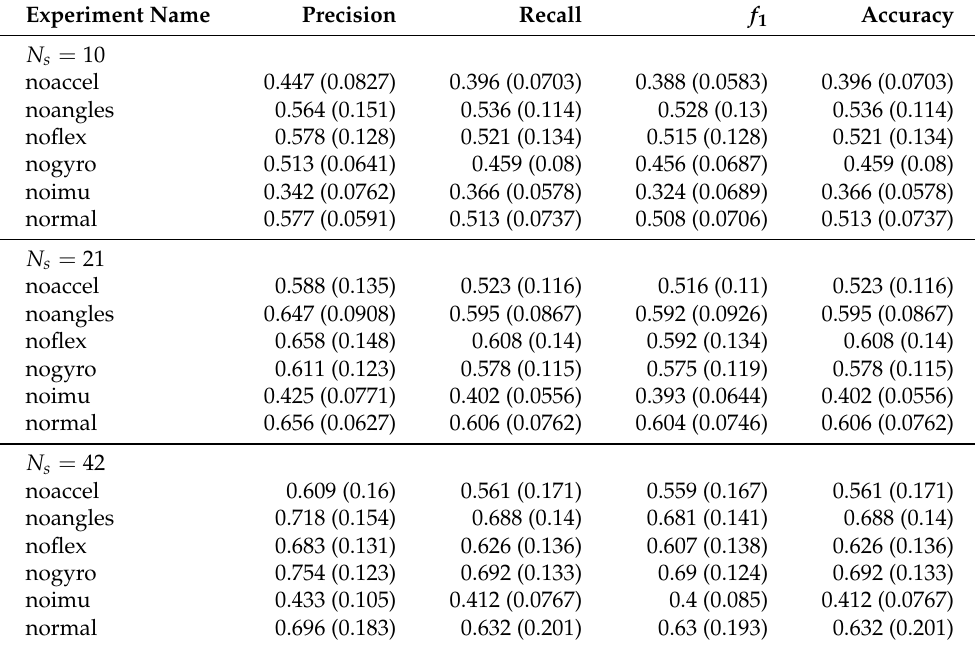
Table A3. Leave-one-out cross validation results for type of training